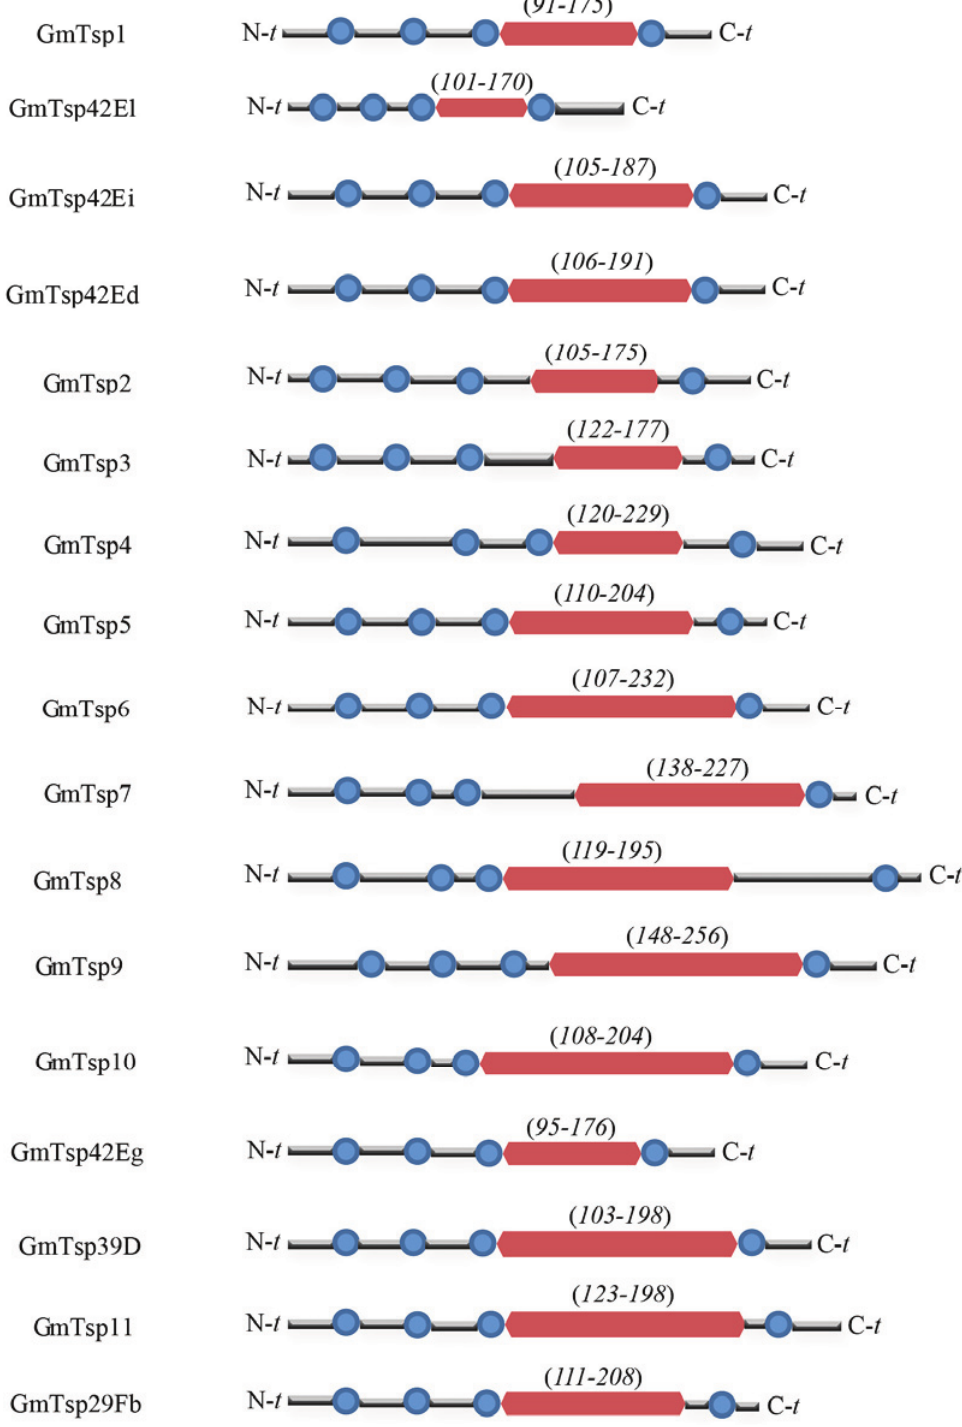
Figure 1. Domain architecture of Glossina morsitans putative tetraspanins. Predicted domain structures of the seventeen G. morsitans are indicated. Transmembrane and large extracellular domain (LEL) domains are depicted as blue round circles and magenta rectangular blocks, respectively. The numbers in the parentheses indicate the coordinates (amino acid residues) of the LEL For details of the coordinates of the TMs, compare this figure with data presented in Table 1 and in Figure A1. N- t and C- t represents the N- and C-termini of the GmTsp proteins,